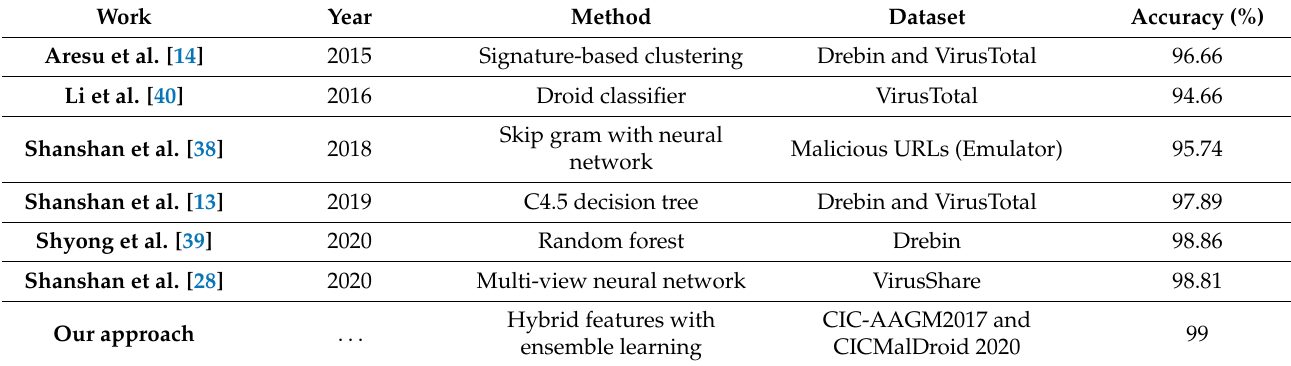
Table 10. Comparison with previously published works.